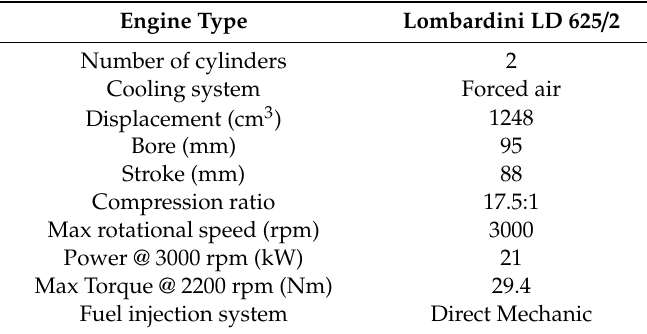
Table 10. Experimental engine